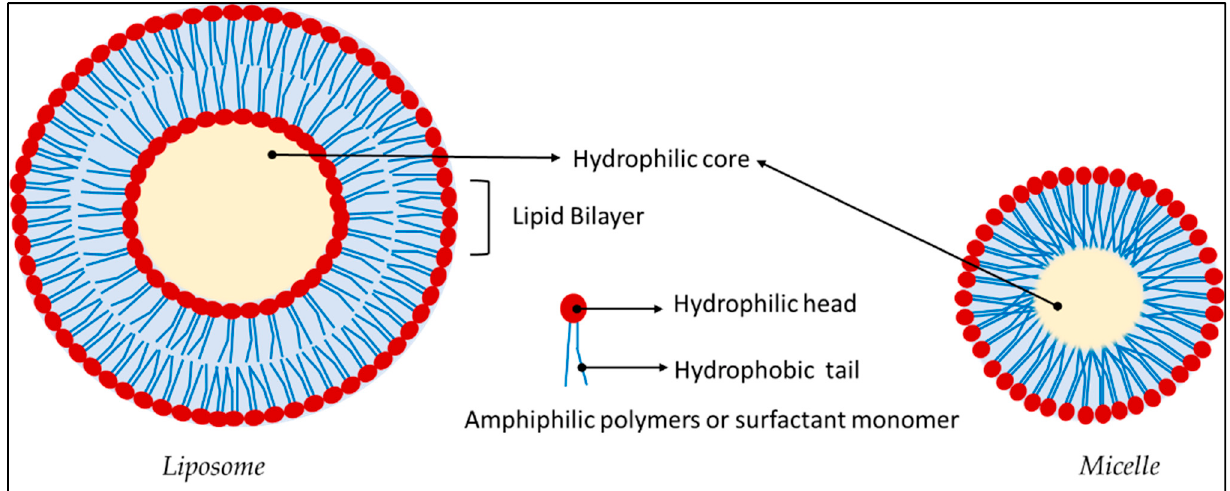
Figure 7. Liposome and micelle consist of an assembly of amphiphilic polymers or surfactant monomers that possess a hydrophobic tail (blue) and a hydrophilic head (maroon).